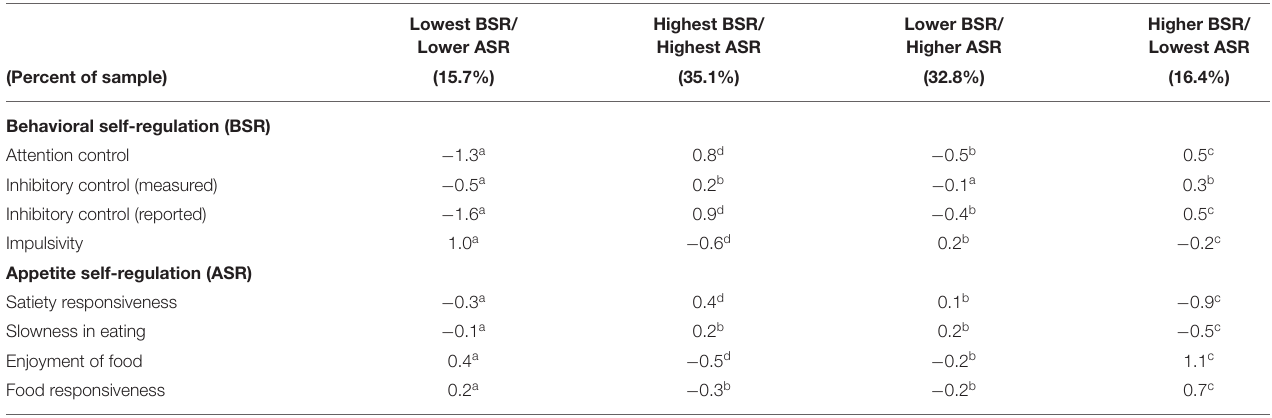
TABLE 3 | Distribution of standardized scores (mean + SE) of behavioral self-regulation (BSR) and appetite self-regulation (ASR) indices by profile